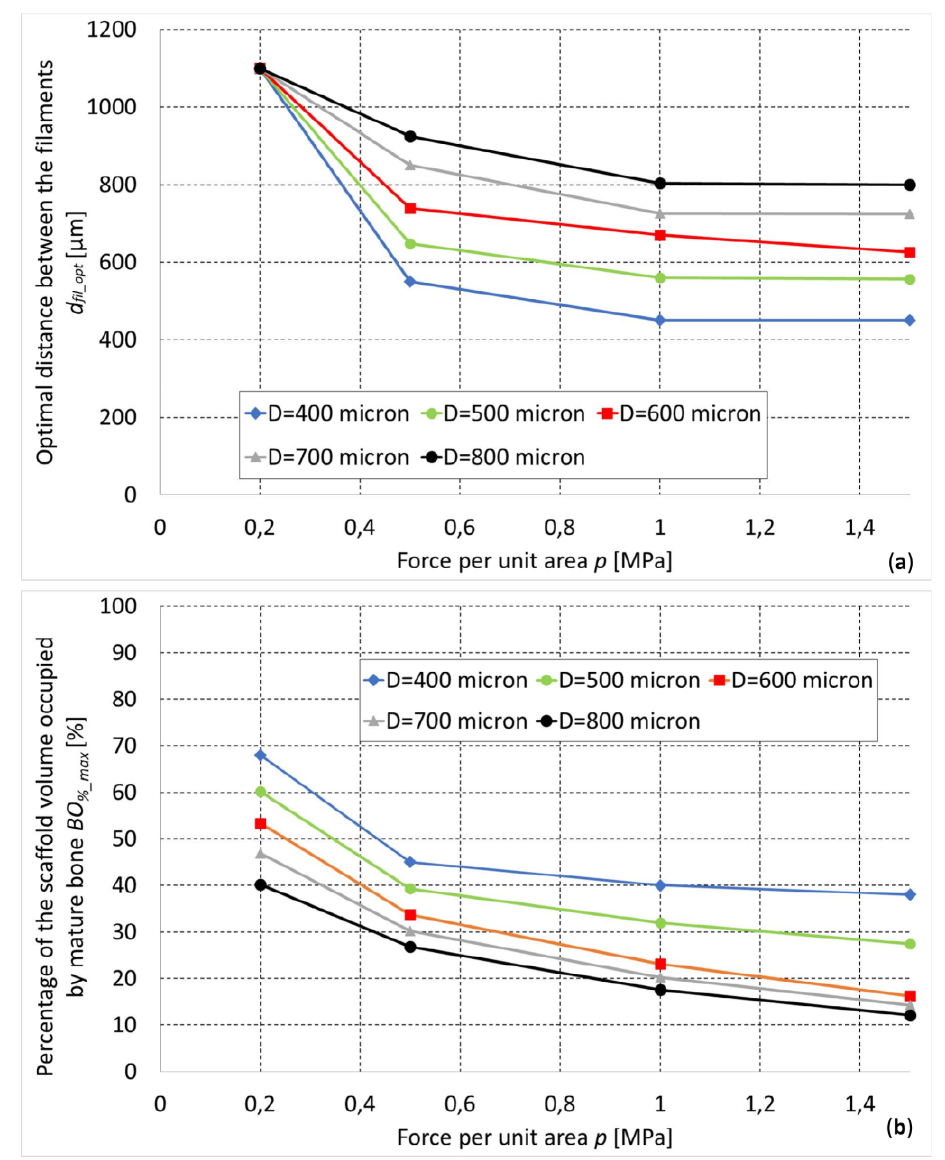
Figure 8. Optimal dimensions of d fil ( a ) and percentage of the scaffold volume occupied by mature bone ( b ) predicted for different values of the load.